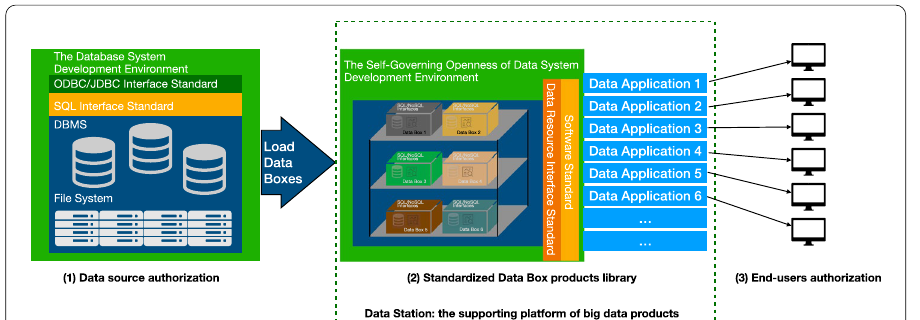
Fig. 1 The supporting system of big data products based on Data Box. Firstly, the platform gets authorization from data sources and load data into Data Boxes. Then the data station stores standardized Data Boxes and serves data applications with proper standards, which are finally provided to end-users through